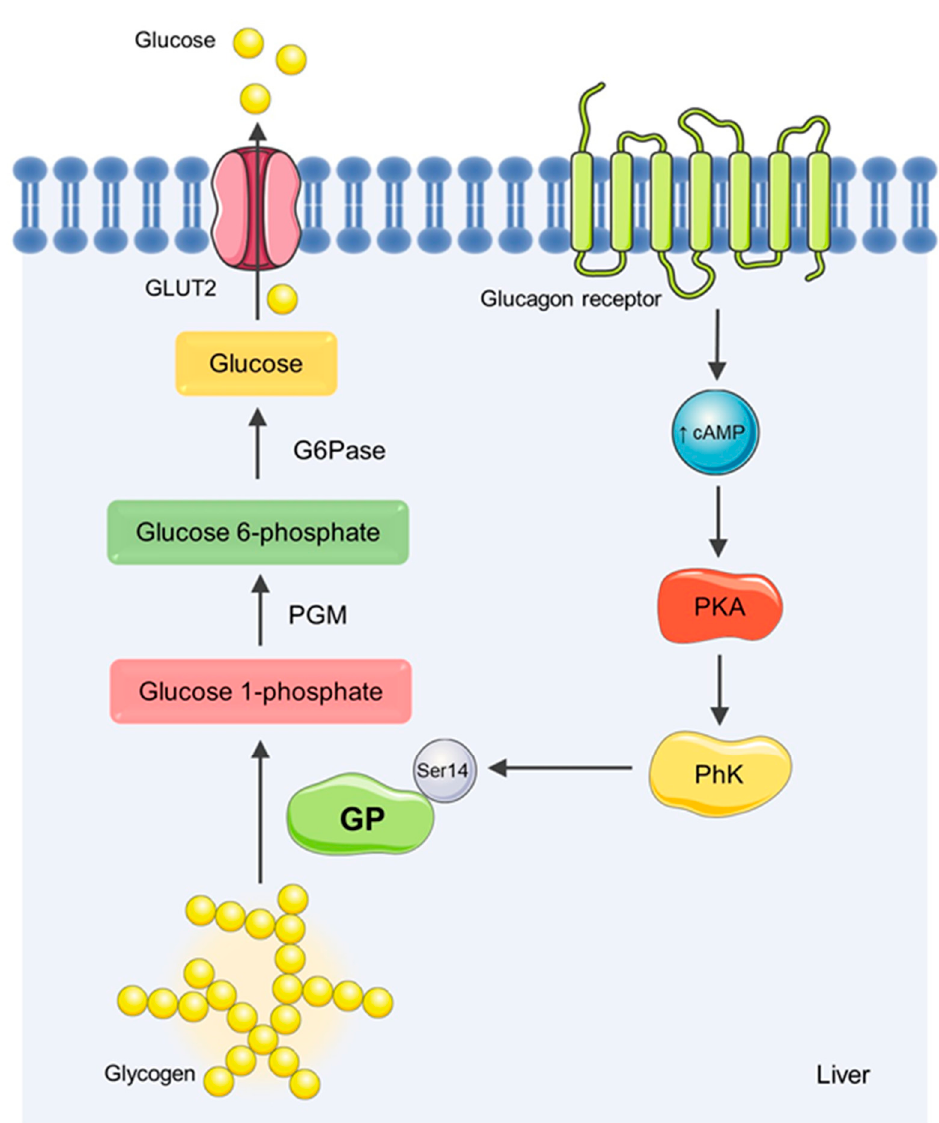
Figure 1. Regulation of hepatic glycogenolysis. Under fasting conditions, glycogenolysis is activated and glycogen synthesis is suppressed. The activation of glucagon receptor induces the increase in intracellular cyclic AMP (cAMP) and the consequent activation of protein kinase A (PKA). PKA is responsible for the phosphorylation of phosphorylase kinase (PhK), which, in turn, activates GP by serine-14 phosphorylation. GP, as a key enzyme involved in glycogenolysis, catalyzes the removal of a glucose residue of the glycogen chain, generating glucose 1-phosphate. Glucose 1-phosphate is converted to glucose 6-phosphate by phosphoglucomutase (PGM), and glucose 6-phosphatase (G6Pase) converts glucose 6-phosphate into glucose, which can be transported to the bloodstream. This process is mediated by glucose transporter 2 (GLUT2). Image bank [17].